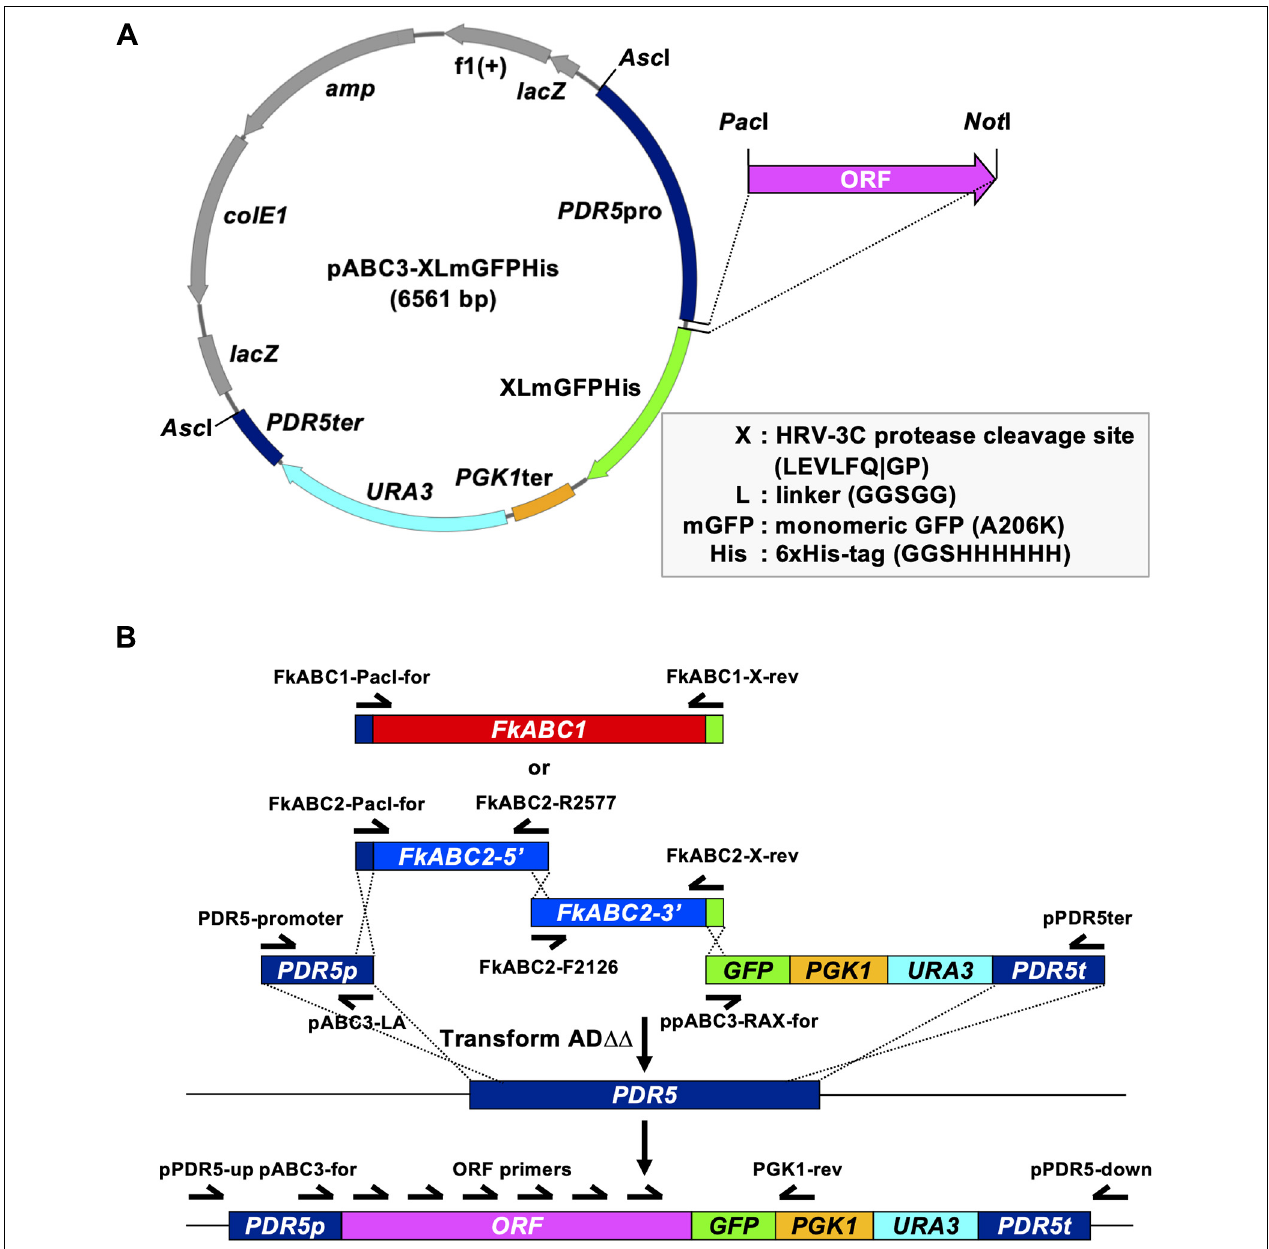
FIGURE 1 | A one-step cloning strategy optimised for the overexpression of fungal PDR transporters in S. cerevisiae AD (cid:49)(cid:49) . (A) The multifunctional pABC3-GFP (Lamping et al., 2007) derivative plasmid pABC3-XLmGFPHis was designed for optimum expression, detection and purification of C-terminally tagged ORFs. Improvements are highlighted in the grey box. pABC3-XLmGFPHis can be used for conventional cloning of any ORF into the Pac I/ Not I restriction sites, as described in Lamping et al., 2007, or it can be used as a template for a much more efficient and faster one-step cloning strategy of any ORF of interest. The grey coloured region represents the pBluescript IISK(+) backbone while the colour-coded region highlights the transformation cassette which comprises the S. cerevisiae PDR5 promoter followed by the XLmGFPHis double tag, the PGK1 terminator, the URA3 selection marker and part of the PDR5 downstream region. (B) FkABC1 (red) and FkABC2 (blue) ORFs were PCR amplified from first-strand cDNA using DNA oligomer primers (half arrows) designed to overlap by 25 bp with the left arm (blue) and right arm (green) DNA fragments. The left and right arm fragments were prepared as gel-purified DNA stocks by PCR amplification from plasmid pABC3-XLmGFPHis using the indicated primers. Due to technical difficulties the FkABC2 ORF was amplified as two separate DNA fragments that overlapped by 25 bp. Equimolar amounts ( ∼ 1 µ g total) of three ( FkABC1 ) or four ( FkABC2 ) PCR amplified DNA fragments were used to transform S. cerevisiae AD (cid:49)(cid:49) and positive Ura + transformants were tested for correct integration of the entire transformation cassette with primers that bound to regions ∼ 40 bp upstream and downstream of the integration site. Correct integration occurred with 100% accuracy via four ( Fk ABC1) or five ( Fk ABC2) homologous recombination events (dashed crossed lines).